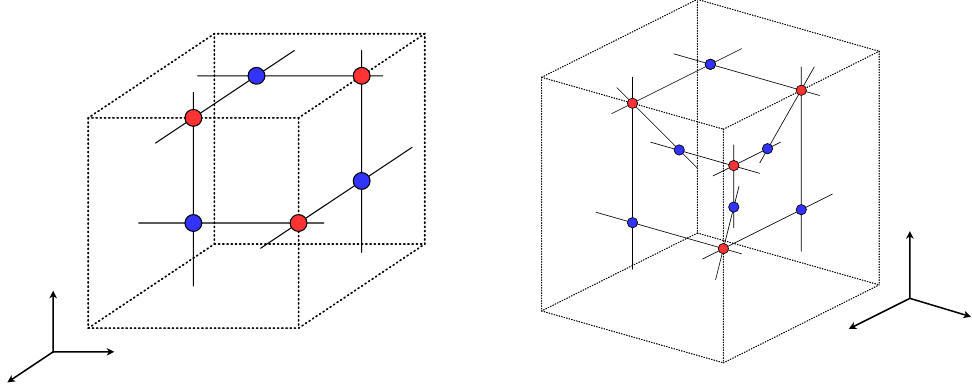
Figure 2 . Structures of T c in eq. (2.11) in Λ 2+1 (left) and Λ 3+1 (right). The lattice geometry in real space is represented by dotted lines in both cases. Red symbols show link tensors in corre- sponding dimensions and blue ones are plaquette tensors. Skewed directions in the four-dimensional description correspond to the forth direction in Λ 3+1